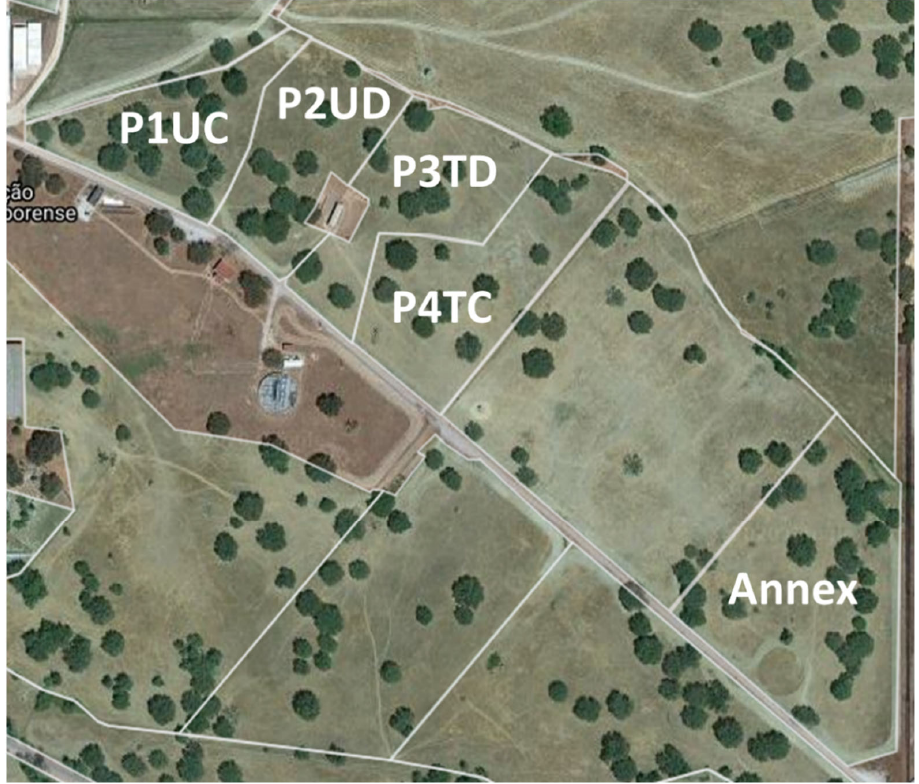
Figure 2. Four areas corresponding to four treatments are represented by U—without dolomitic limestone, T—with dolomitic limestone, C—continuous grazing, D—deferred grazing within the study area and remaining annex area.